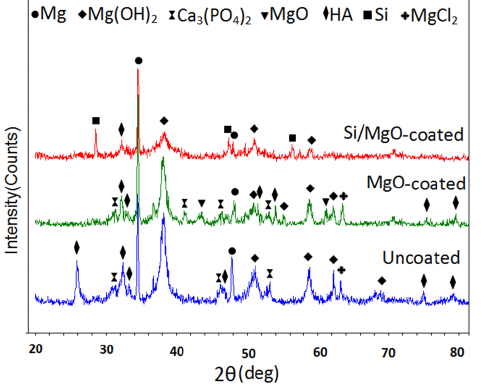
Figure 10. XRD patterns of uncoated, MgO ‐ coated and Si/MgO ‐ coated after 168 h of immersion in an SBF solution at 37 °C.